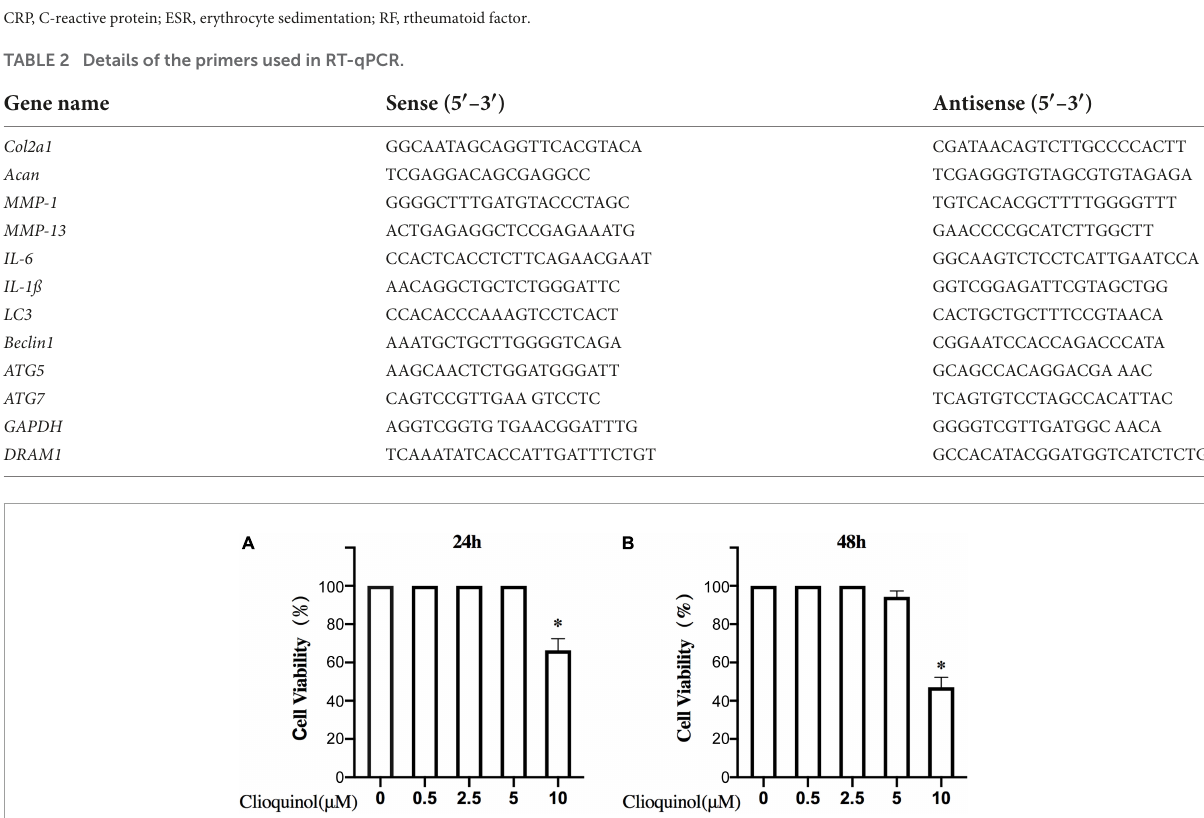
FIGURE1 Effects of clioquinol on the cell cytotoxicity in vitro . The cytotoxic effects of clioquinol on chondrocytes were determined with increasing concentrations (0, 0.5, 2.5, 5, and 10 µ M) for 24 and 48 h using a CCK8 assay (A,B) . All experiments were repeated five times. All data are shown as the mean ± SD. ∗ p <